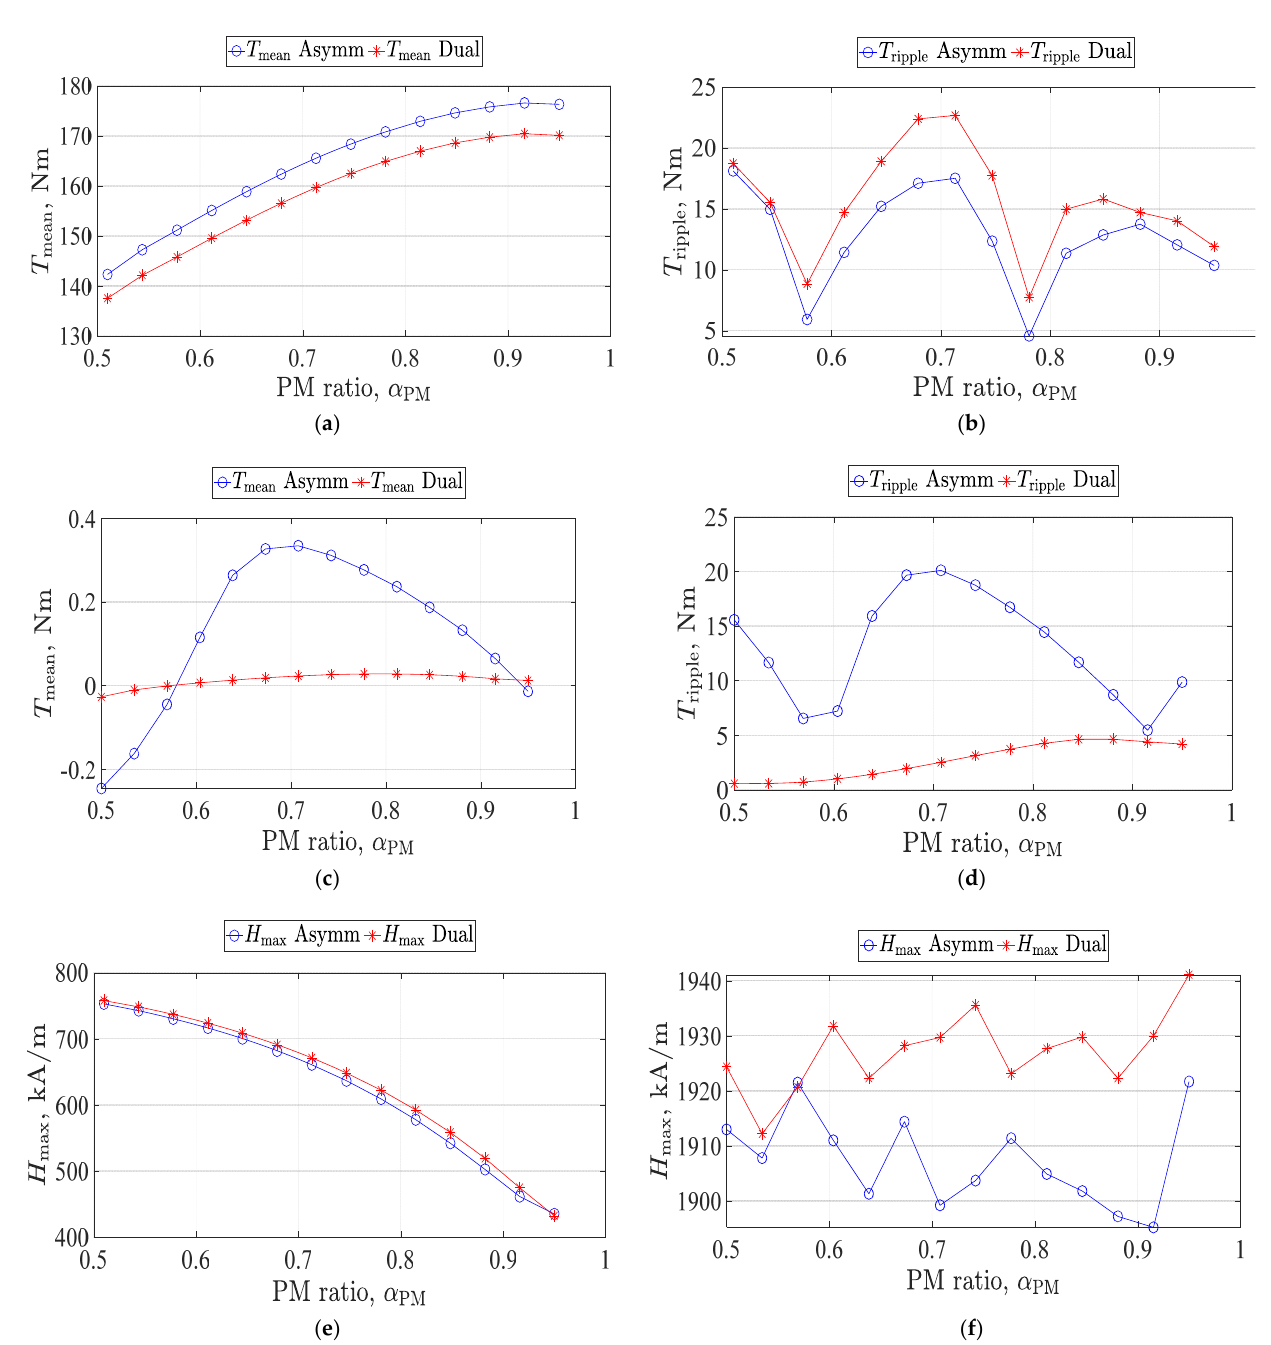
Figure 9. Torque profiles and maximum PM magnetic field intensity with respect to PM width ‐ to ‐ pole pitch ratio. ( a ) Average torque under propulsion. ( b ) Torque ripple under propulsion. ( c ) Average torque under charging. ( d ) Torque ripple under charging. ( e ) Maximum magnetic field intensity in the PMs under propulsion. ( f ) Maximum magnetic field intensity in the PMs under charging.